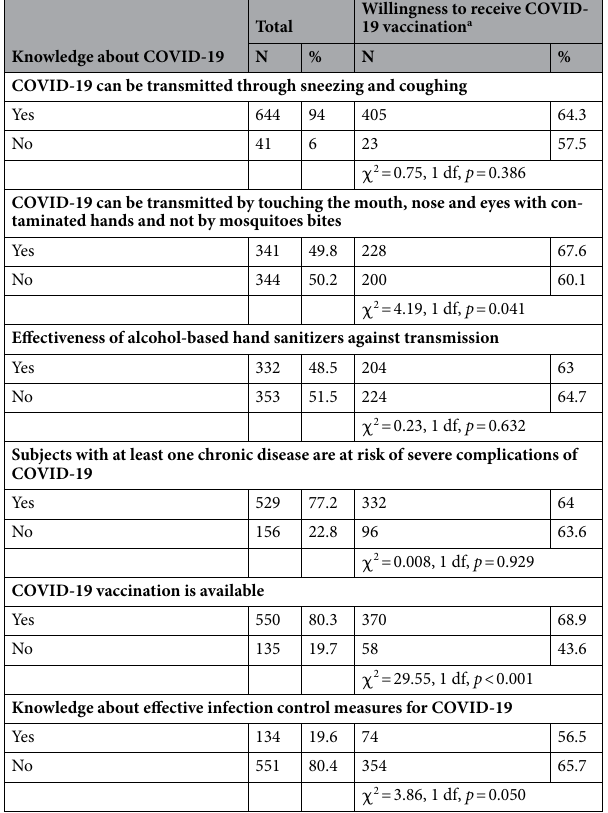
Multivariate regression analysis. To have insight into the independent role of multiple determinants of the outcomes of interest, multivariate logistic regression models were built and the results are reported in Table 4. In the model performed to explore the association between the participants’ perception of risk of devel- oping COVID-19, those who felt to be at high risk were significantly more likely to be affected by chronic dis- eases (OR = 2.68; 95% CI 1.73–4.16), to report at least one common symptom compatible with COVID-19 in the previous 3 months (OR = 1.55; 95% CI 1.03–2.35), to be older (OR = 1.06; 95% CI 1.04–1.08), to perceive to be at high risk of severe complications caused by COVID-19 (OR = 2.4; 95% CI 1.32–4.35), to believe that COVID-19 will cause serious consequences in their institution (OR = 3.12; 95% CI 1.59–6.12), to be less aware of the effec-